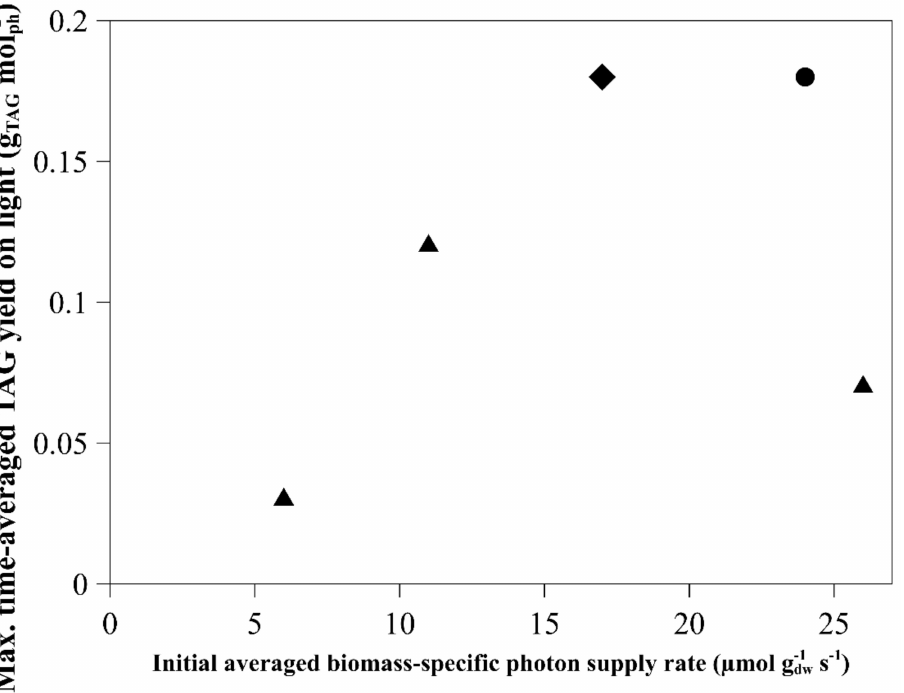
Figure 2. Maximal time-averaged triacylglycerol (TAG) yield on light (g TAG mol ph − 1 ) reached in the experiments at the initial averaged biomass-specific photon supply rates as shown in Figure 1. The light regime used: continuous (circles), sinus (triangles) and block (diamonds)